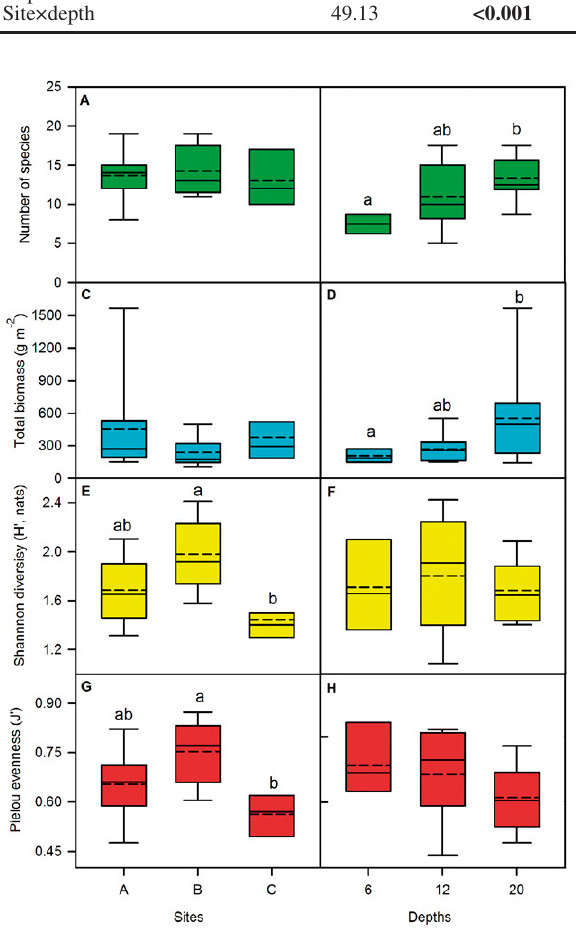
Fig. 2. – Structure of reef fish assemblages at three sites and three depths at Clipperton Atoll. Species richness per site (A) and depth (B); total biomass per site (C) and depth (D). Shannon diversity (H ′ ) per site (E) and depth (F); Pielou evenness (J ′ ) per site (G) and depth (H). In the box and whisker plots, means are dotted lines, 50th per- centiles (medians) are solid lines, and boxes correspond to the 25th and 75th percentiles. Error bars mark the 5th and 95th percentiles. The lowercase letters correspond to the Tukey HSD test